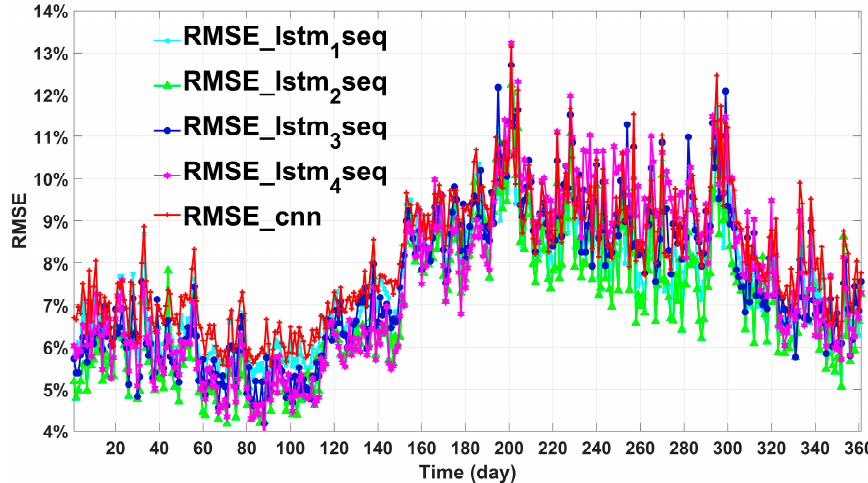
Figure A1. SSIM comparison for different input sequence lengths. The blue, light green, red, and black lines represent the SSIM of ConvLSTM at the input time series of 1, 2, 3, and 4 days, respec- tively. The magenta line represents the SSIM of CNNs.